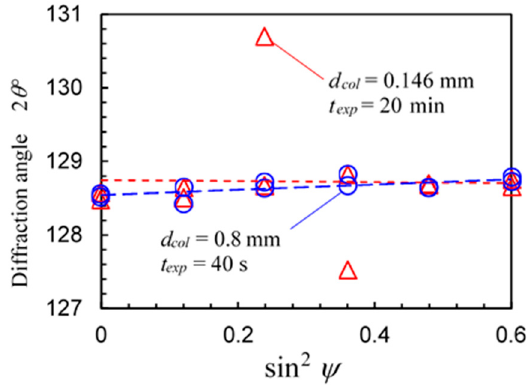
Figure A1. Relationship between sin 2 ψ − 2 θ ( d col = 0.146 mm, t exp = 20 min and d col = 0.8 mm, t exp = 40 s).